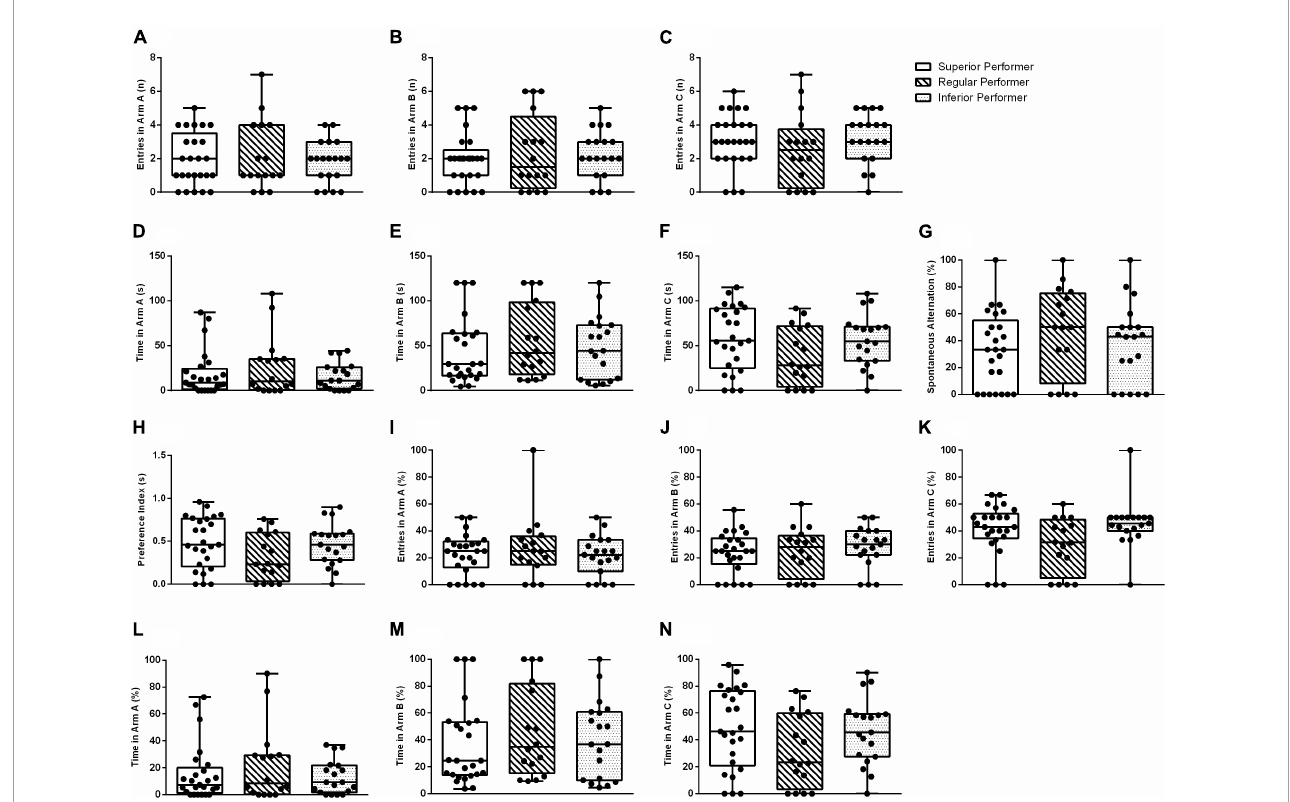
FIGURE3 Spatial memory in the Y-maze test. (A) Entries in arm A, (B) entries in arm B, (C) entries in arm C, (D) time spent in arm A, (E) time spent in arm B, (F) time spent in arm C, (G) % spontaneous alternation, (H) preference index, (I) % entries in arm A, (J) % entries in arm B, (K) % entries in arm C, (L) % time spent in arm A, (M) % time spent in arm B, and (N) % time spent in arm C. Data are expressed in 25–50–75 percentile and range (minimum and maximum). The Kruskal–Wallis and Mann–Whitney tests were used.